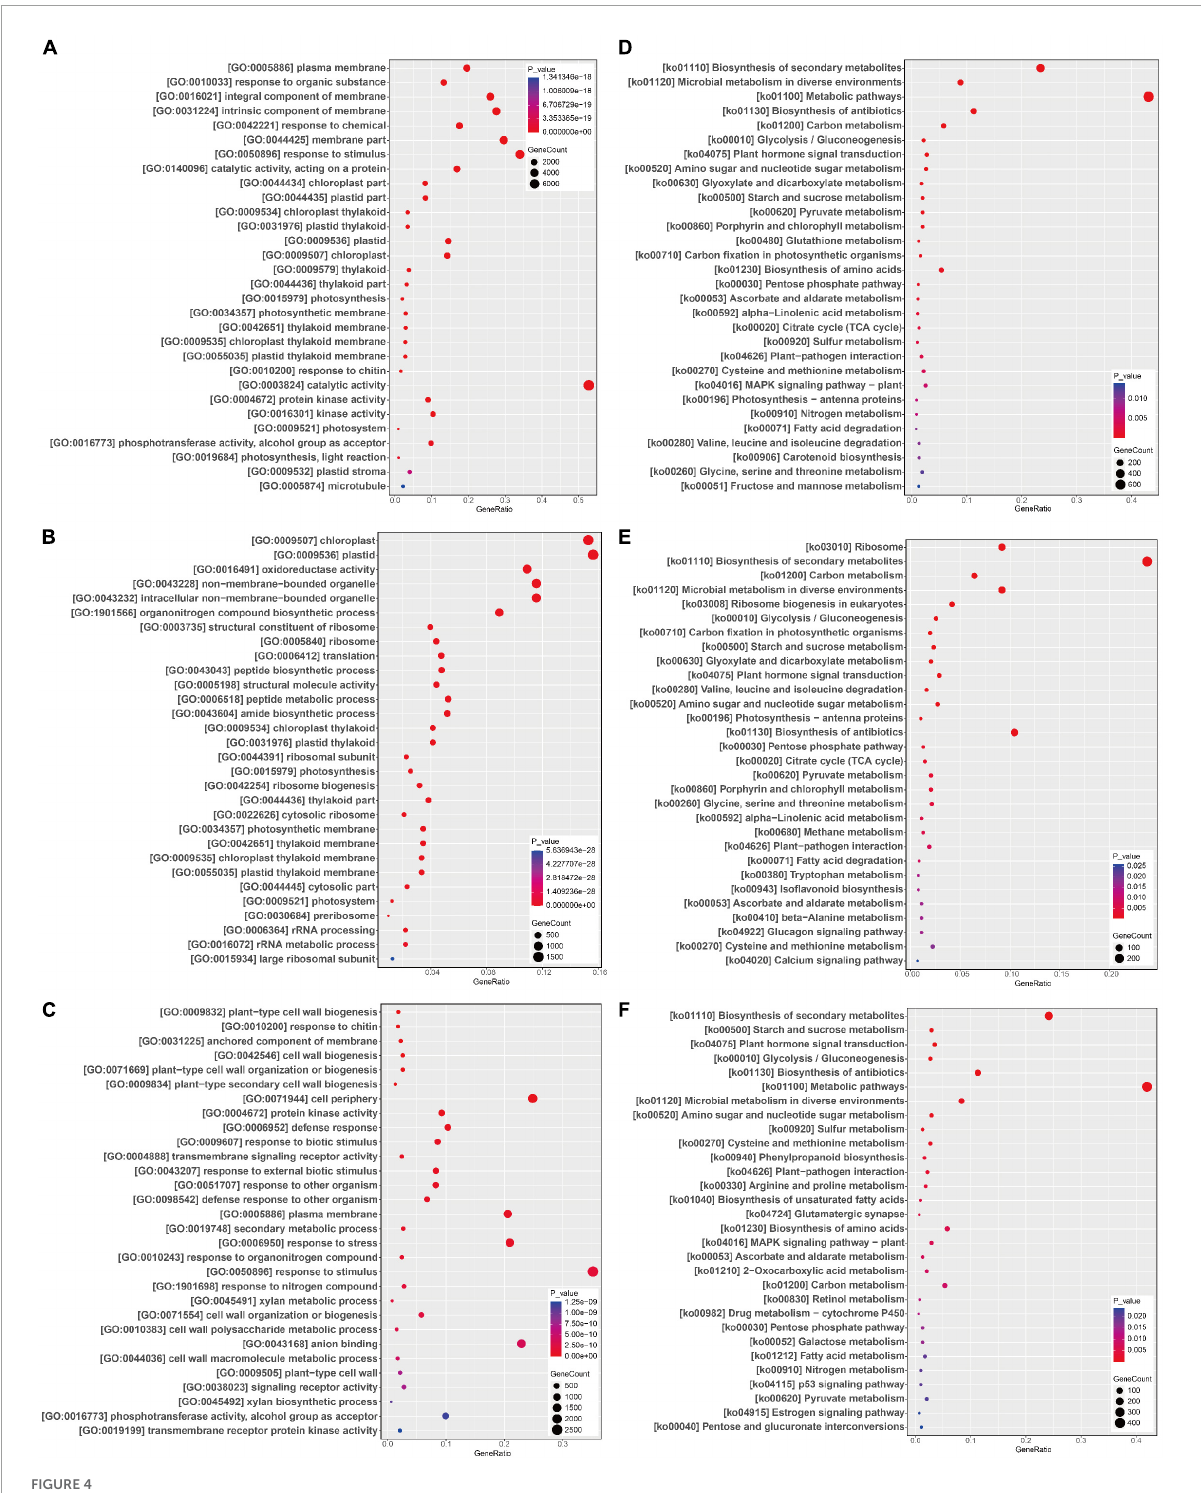
FIGURE4 GO functional and KEGG pathway enrichment analysis of differentially expressed genes (DEGs). DEGs GO functional and KEGG pathway enrichment analysis in paired comparison of Gm-Ss vs. Gm (A,D) , Gm-Ba vs. Gm (B,E) , and Gm-Ba-Ss vs. Gm-Ss (C,F) . The abscissa GeneRatio represents the proportion of DEGs belonging to a GO term and KEGG pathways in all DEGs; The larger the bubble, the more DEGs; Color indicates P -value, representing the significance of enrichment. The darker the color, the more significantly enriched the GO term and KEGG pathways. The right color gradient indicates P